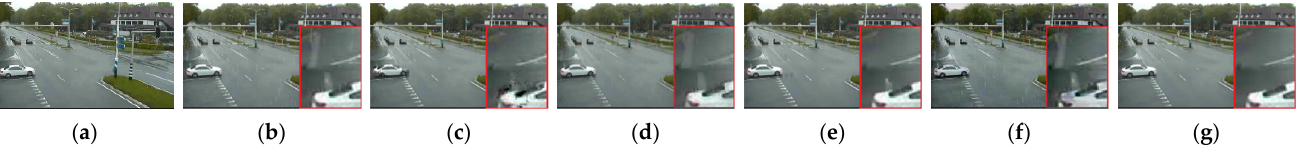
Figure 5. Comparison on a synthetic rain video. ( a ) Ground truth, ( b ) input, ( c ) Kim et al. [16], ( d ) Wang et al. [8], ( e ) Li et al. [14], ( f ) Chen et al. [32], ( g ) proposed method.